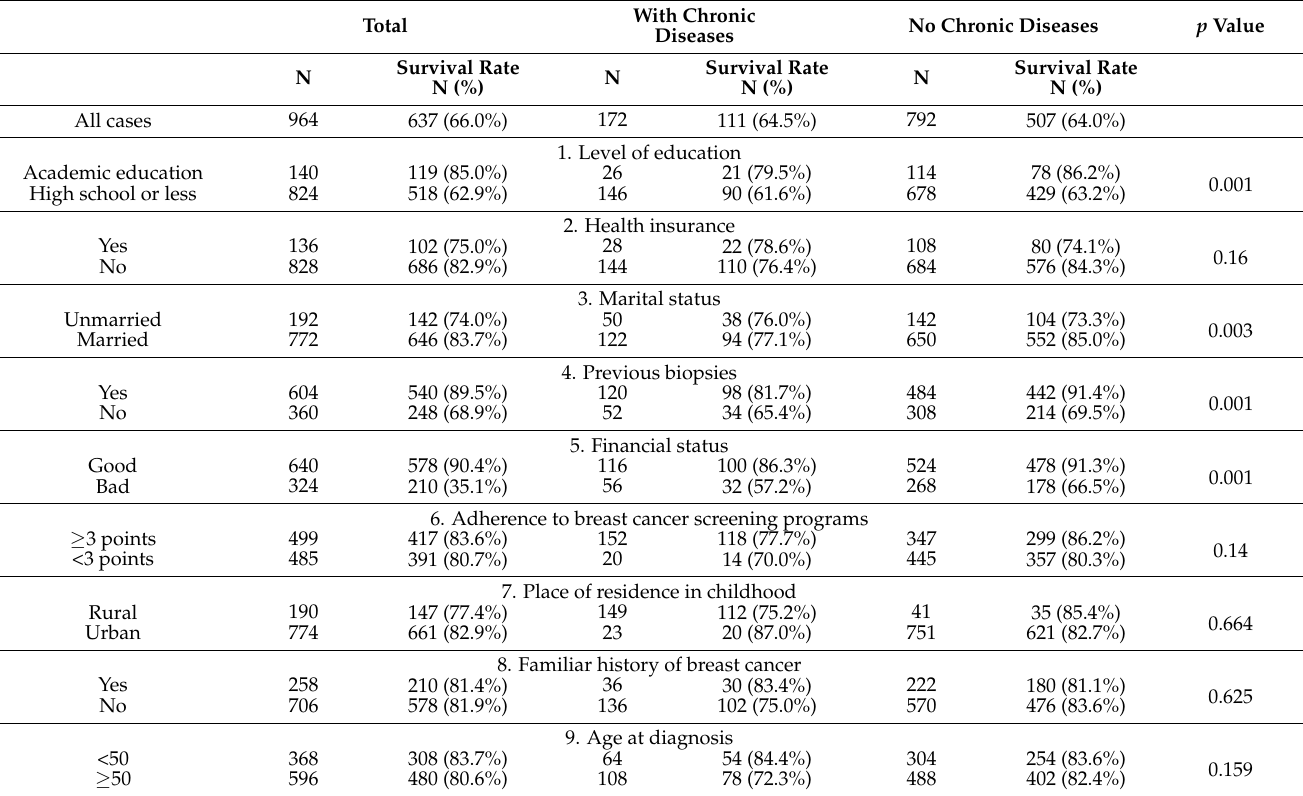
Table 2. Survival analysis stratified by the presence of chronic diseases other than